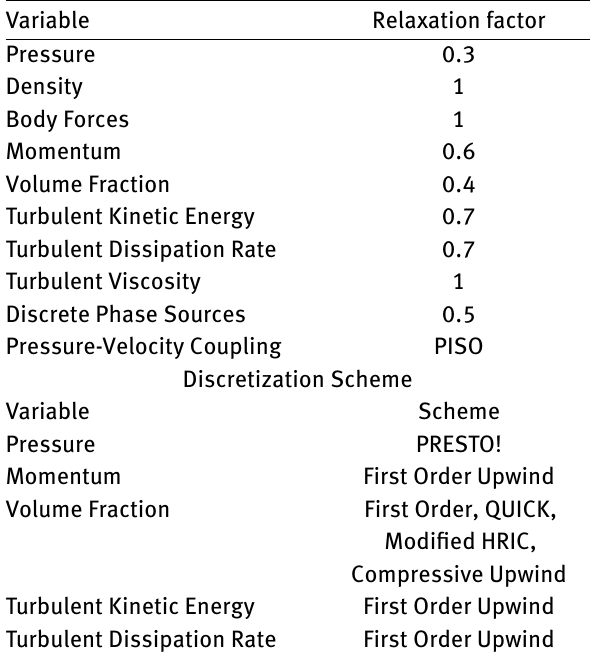
Table 6: Summary of the numerical solution solver setting Variable